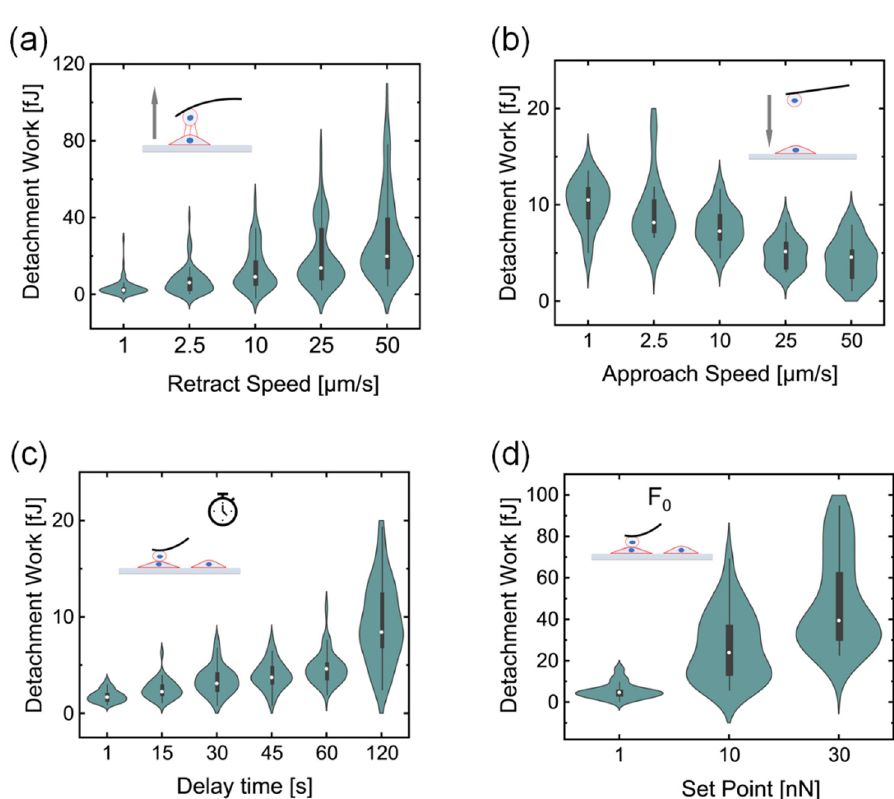
Figure 2. Influence of the experimental settings on cell-cell interactions. ( a , b ) show the distribution of the work spent to detach the probe cell from the target cell when the retraction speed ( a ) and the approach speed ( b ) were modified. ( c , d ) display the effect of the delay time τ ( c ) and setpoint force ( d ) in the distribution of the adhesion work.